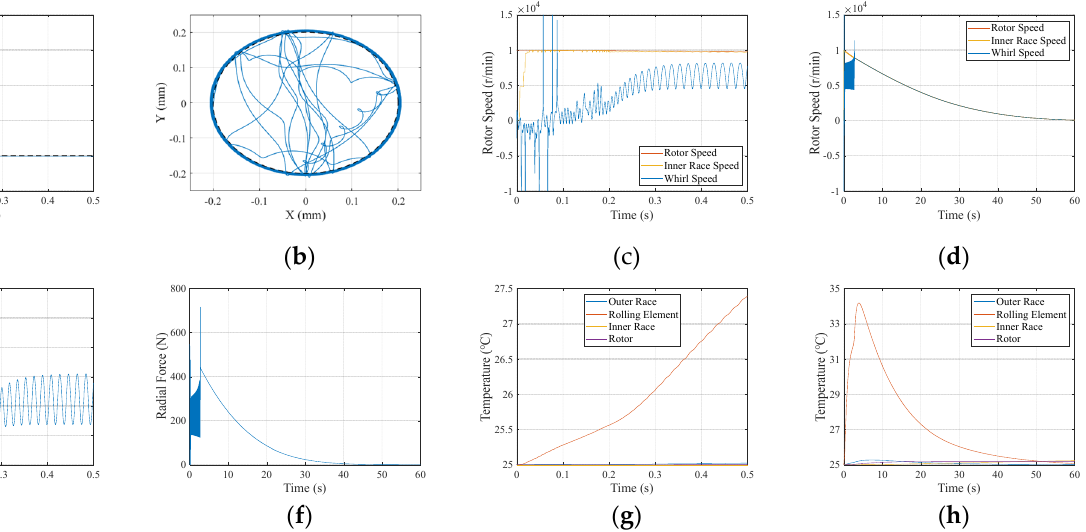
Figure 9. Numerical simulation results of the rotor touchdown at 5000 r/min: ( a ) Axial displacement, ( b ) Radial trajectory, ( c ) Rotor speed change in the first 0.5 s, ( d ) Rotor speed change for the whole process, ( e ) Radial contact force of the TDB in the first 0.5 s, ( f ) Radial contact force of the TDB for the whole process, ( g ) Temperature change in the first 0.5 s, ( h ) Temperature change for the whole